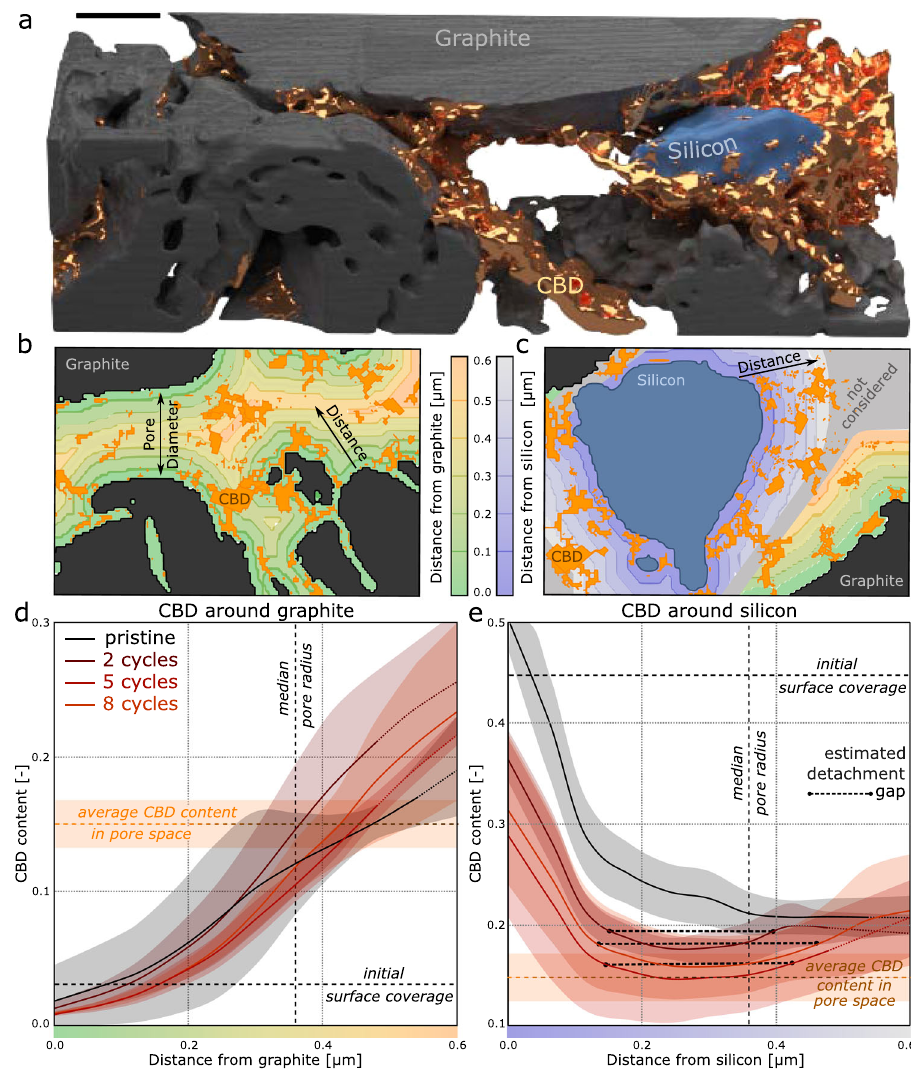
Fig. 8 Evolution of microstructure with cycling. Reconstruction of a subvolume ( a ) of a pristine electrode showing how the carbon black-binder domain (CBD) (gold) clusters in pores, particularly around silicon particles (blue). Illustration showing how concentric shells around the graphite ( b ) and silicon phases ( c ) are de fi ned. The CBD content in shells emanating around graphite ( d ) and silicon ( e ) particles for the pristine sample (black) and for samples cycled two, fi ve and eight times. The shading represents the standard deviation of the three samples. Near silicon particles, the positioning of CBD changes indicating detachment and gap formation (dashed lines) upon electrode cycling. Scale bar is 2 μ